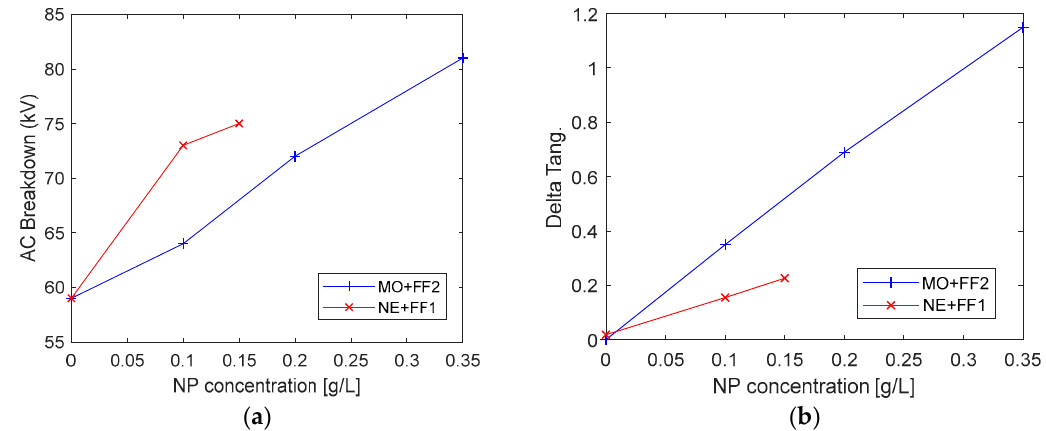
Figure 5. ( a ) AC Breakdown Voltage (50 Hz) and ( b ) Tangent delta of the prepared DNF.